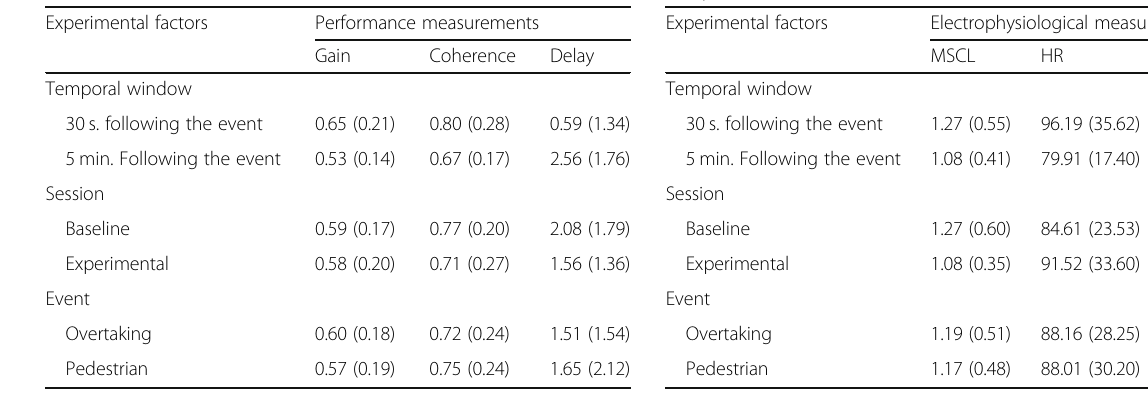
Table 1 Mean values of gain, coherence and delay as a function of temporal window, session and event (SD in brackets)